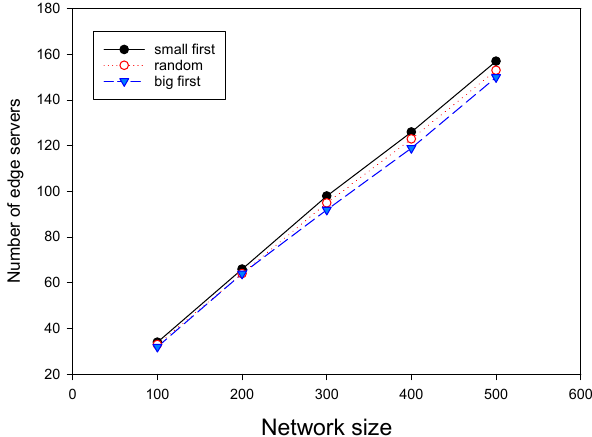
Figure 8. The impact of cluster rebuilding strategy on the number of edge